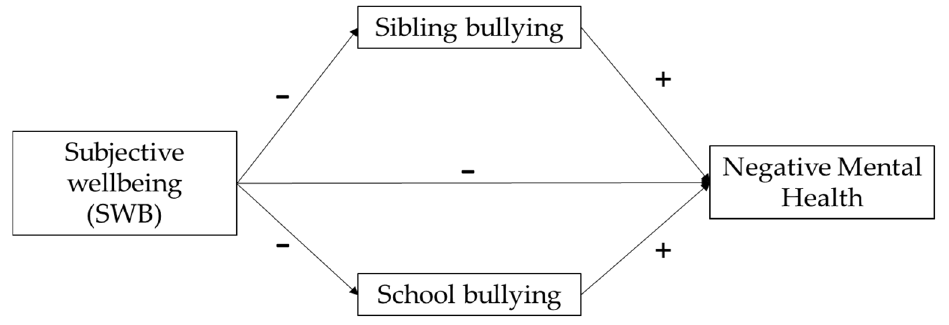
Figure 1. Conceptual model.